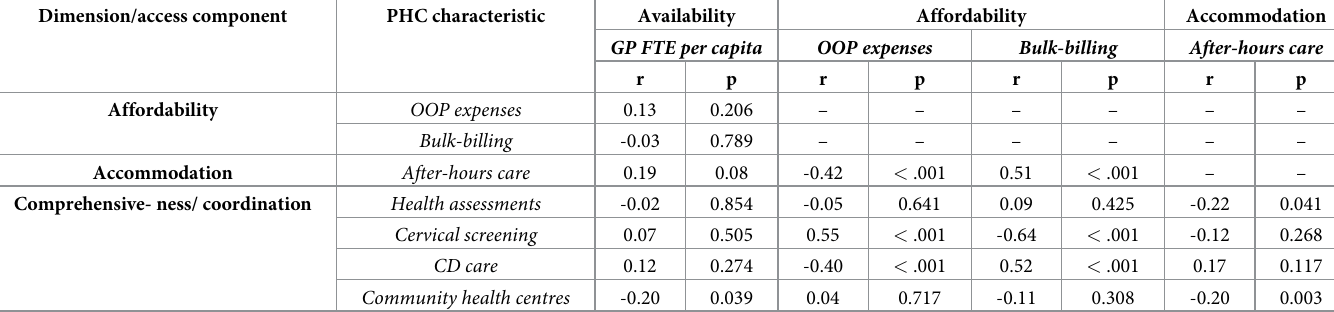
Table 4. Correlation between dimensions of area PHC service characteristics (including components of